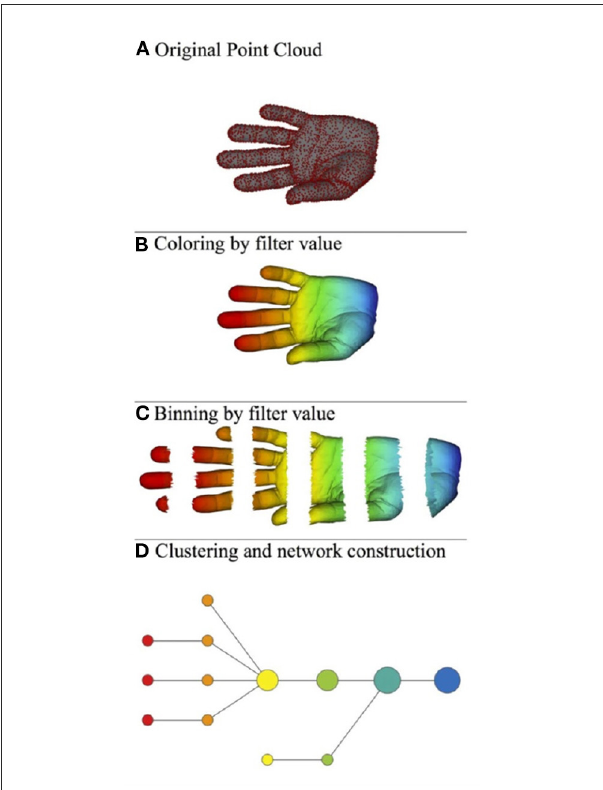
FIGURE2 Illustration of the mapper algorithm in the case of a point cloud S in R 2 , and with the filter function given by the horizontal projection. The outcome of this algorithm is the bottom graph. (A) Original point cloud, (B) Coloring by filter value, (C) Binning by filter value, and (D) Clustering and network